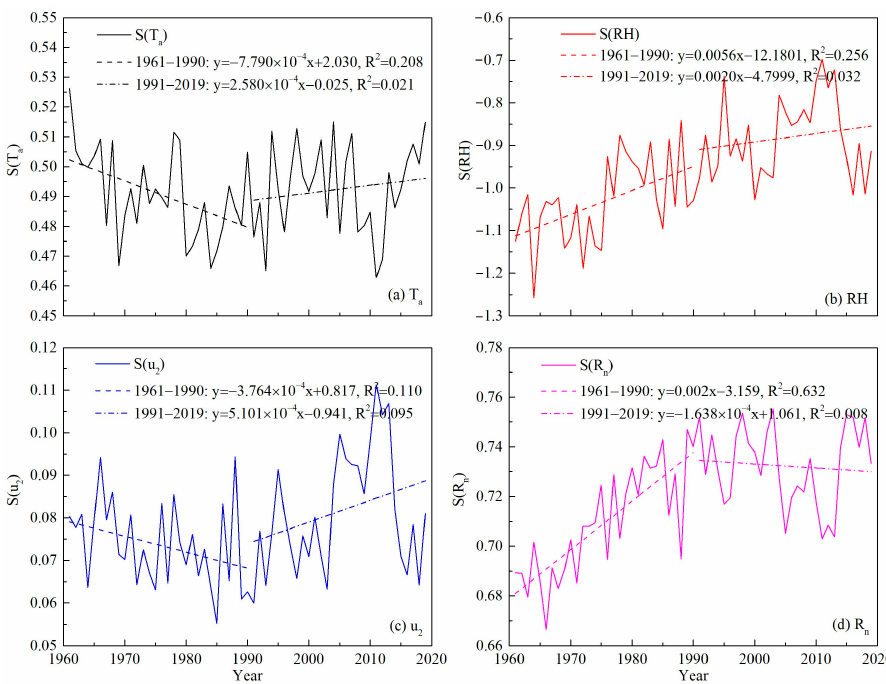
Figure 6. Changes of annual sensitivity coefficients of meteorological factors ( a ) T a , ( b ) RH, ( c ) u 2 , ( d ) R n to ET 0.